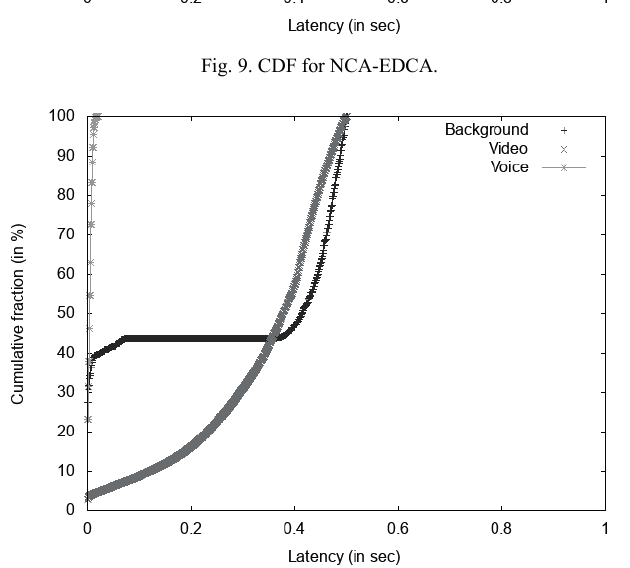
Fig. 10. CDF for EDCA.